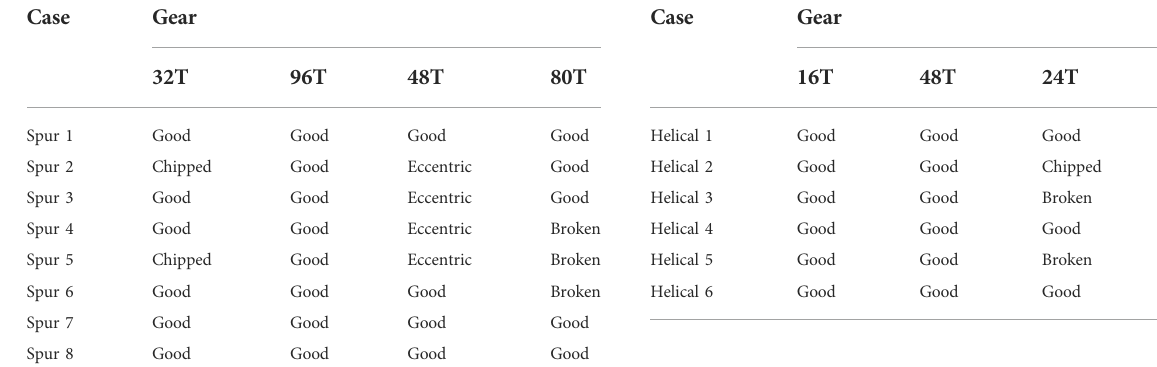
TABLE 1 Details for spur gears with different fault moods. TABLE 2 Details for spur gears with different fault